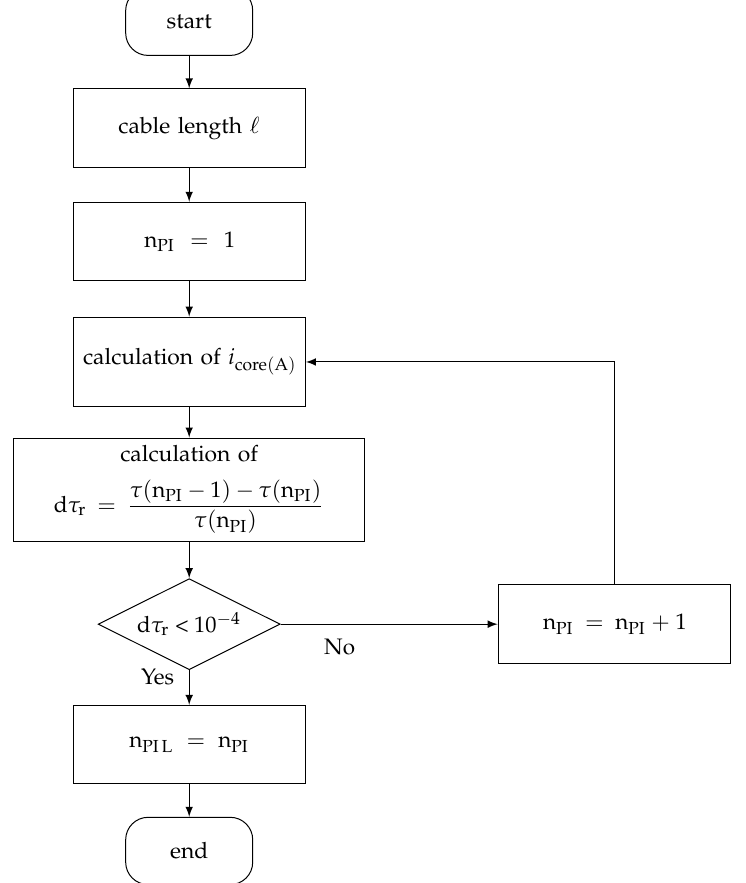
Figure 11. Optimization the number of PI-sections—first